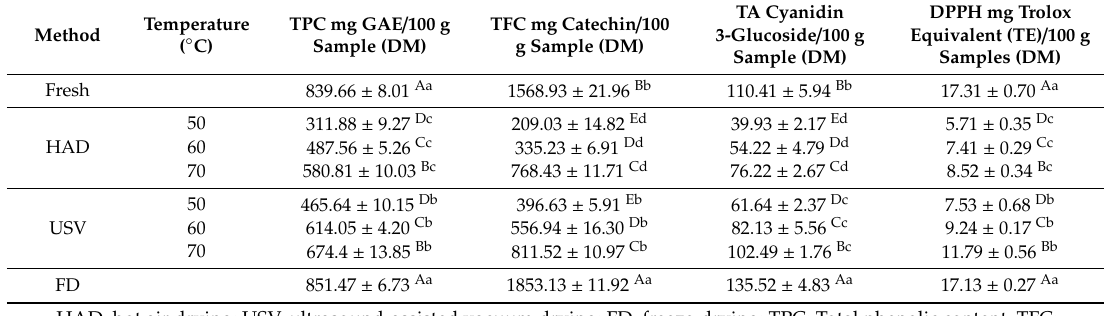
Table 1. E ff ect of total bioactive compounds of cherry